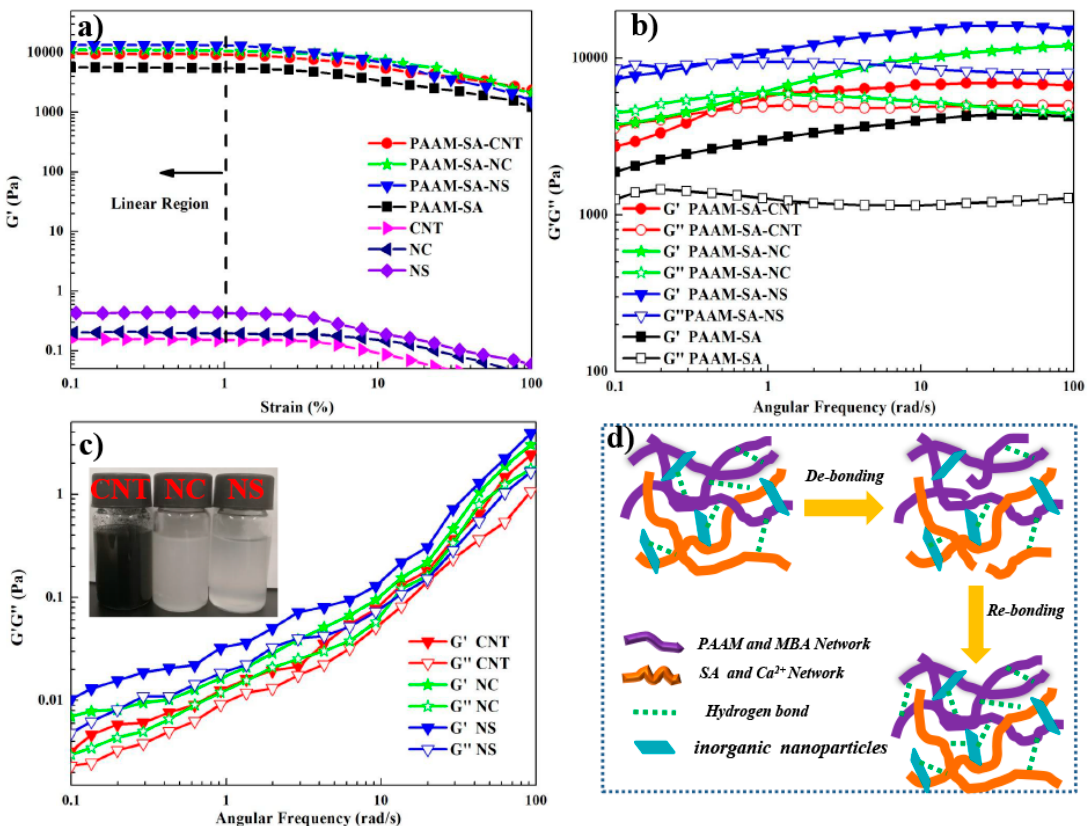
Figure 6. Dynamic viscoelasticity performance of the hydrogels at 25 °C: ( a ) strain dependence of storage modulus of hybrid hydrogels and 0.1% inorganic nanoparticle suspension at frequency of 1.0 Hz; ( b ) frequency dependence of storage and loss modulus of hydrogels; ( c ) frequency dependence of storage and loss modulus of 0.1% inorganic nanoparticle suspension; and ( d ) schematic illustration of the mechanism of fracture and rebuilding of hydrogen bonds.